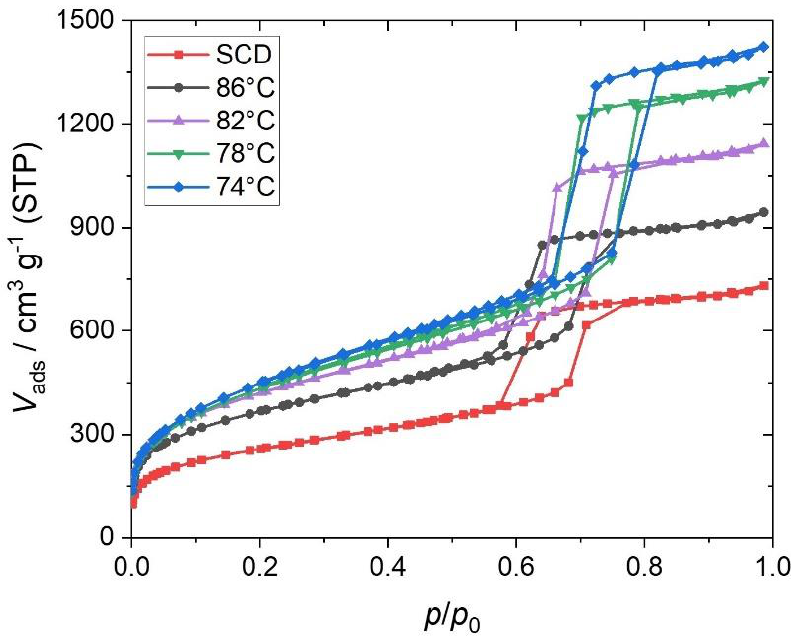
Figure 3. Selected nitrogen physisorption isotherms for the hierarchically organized silica materials after the respective drying process.